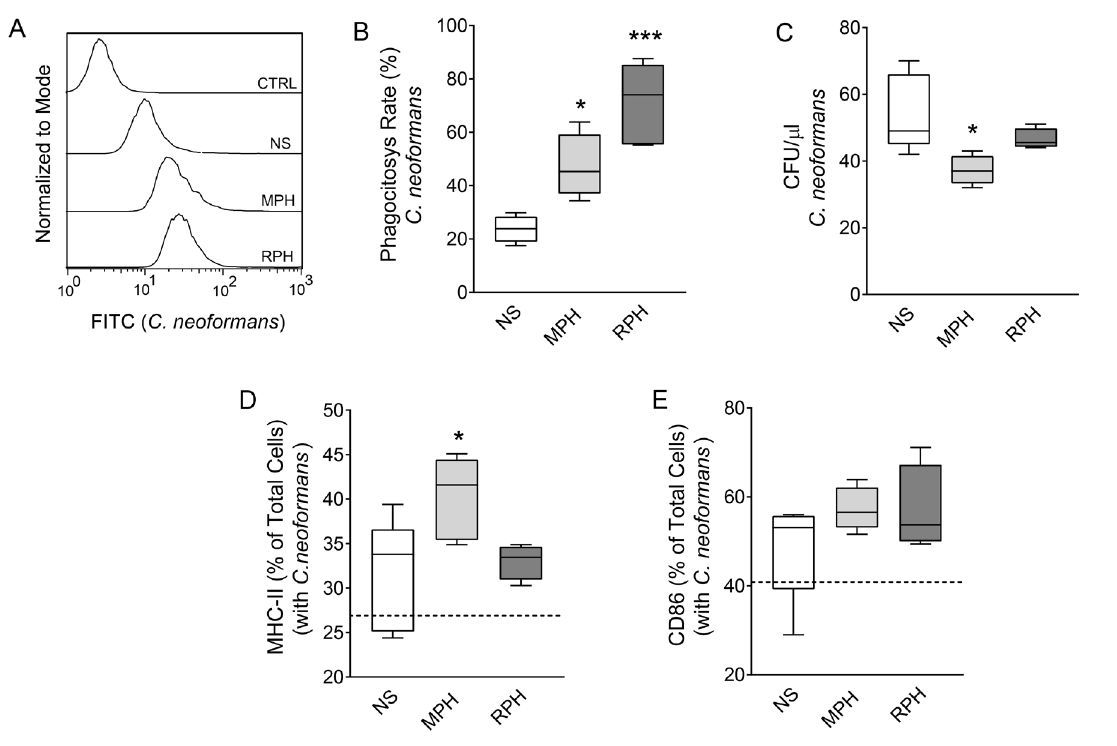
Figure 4. Hemolymph increases the phagocytosis rate and the microbicidal activity in RAW264.7 macrophages. (A) Histograms of the internalized fungus (stained with FITC) in RAW 264.7 cells. (B) Phagocytosis rate of C. neoformans by RAW 264.7 cells. The fungi were incubated with the cells for 4 hours. (C) Colony Forming Units (CFU) for μL of lysate from macrophages incubated with C. neoformans . RAW 264.7 macrophages were incubated with C. neoformans for 48 hours, in the presence or not of both hemolymph samples. (D-E) Expression of MHC-II and CD86 in macrophages stimulated with both hemolymph samples. The dashed lines represent the relative expression of the control without C. neoformans . Results representative of one experiment. The significances are relative to the NS group. * p < 0.05; ** p < 0.01; *** p <